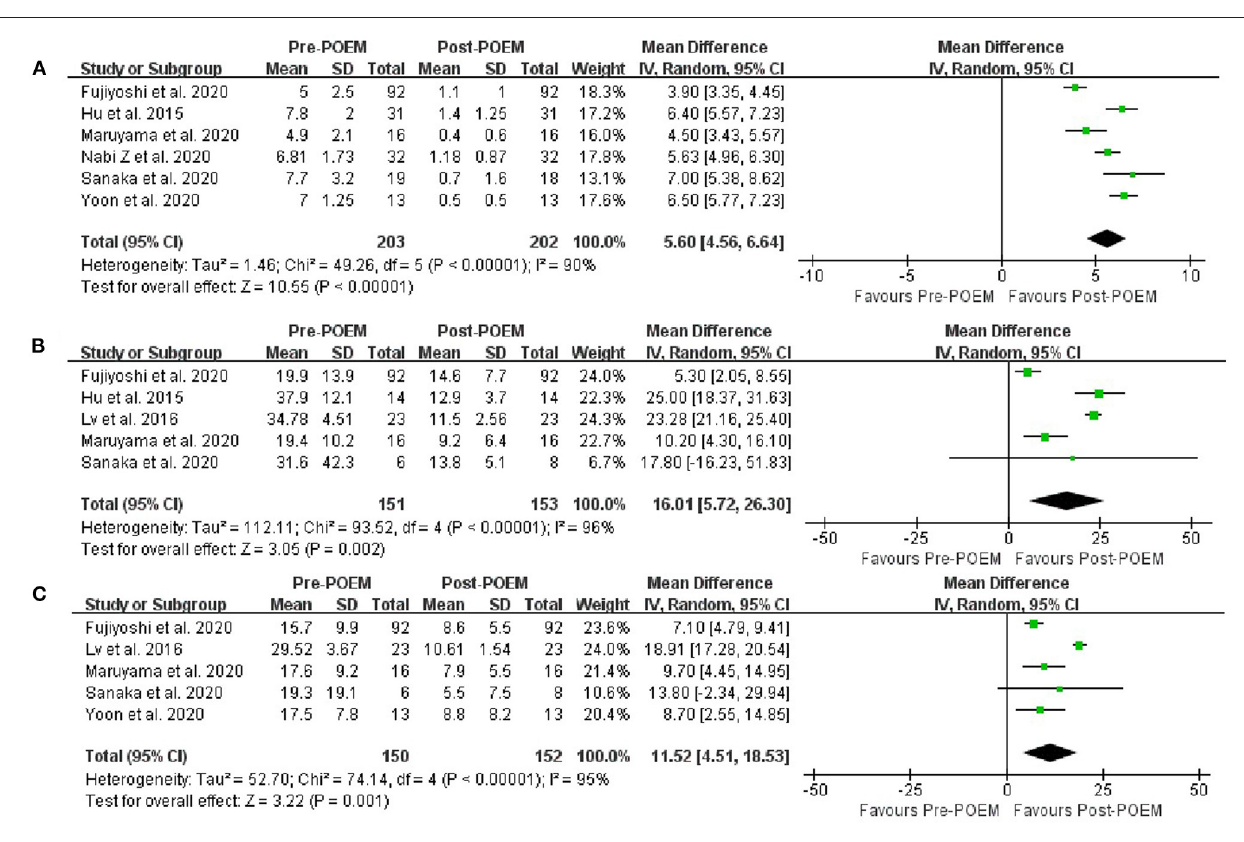
POEM is challenging for sigmoid-shaped achalasia. Firstly, patients with severe esophageal stasis may have submucosal inflammation and fibrosis, which hinder the establishment of submucosal tunnel. Secondly, the severe bending angle of sigmoid-shaped achalasia makes the establishment of submucosal tunnel technically challenging ( 15, 25). In